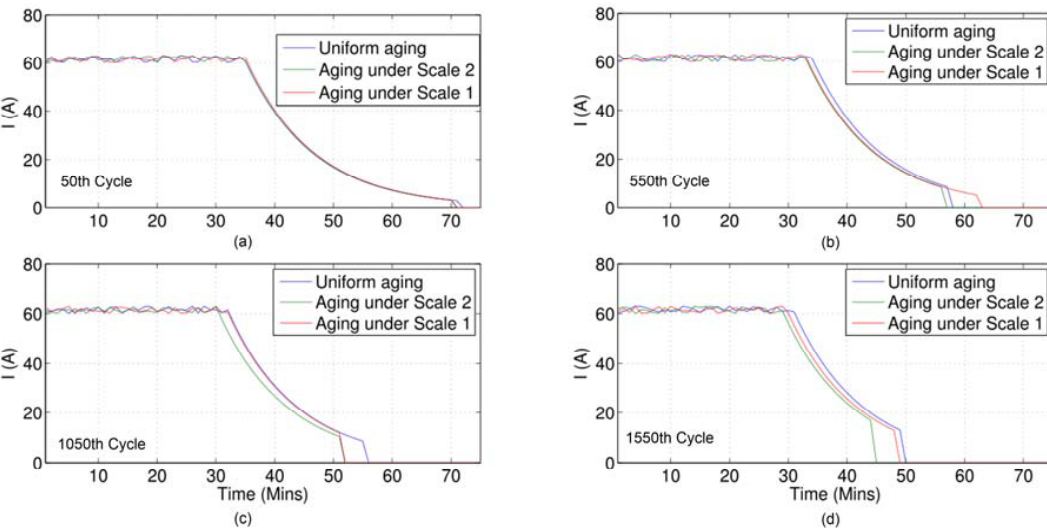
Figure 5. The charging profiles of the SBS (LFP) with uniform and non ‐ uniform aging. ( a ) 50th Cycle; ( b ) 550th Cycle; ( c ) 1050th Cycle; ( d ) 1550th Cycle.